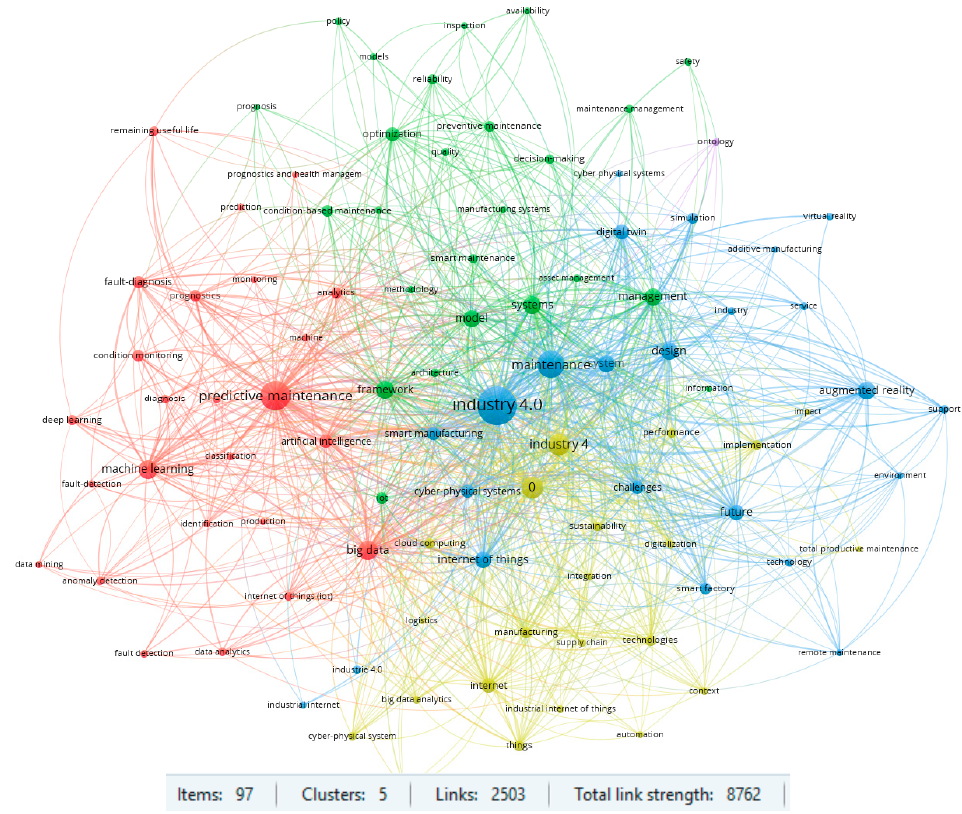
Figure 13. Analysis of keyword strength for the analyzed 1113 publications from the WoS database. Source: own development using VOSviewer software [101]. Two clusters for the item ‘predictive maintenance’ and for ‘Industry 4.0’ are particu- larly noteworthy in the area under review. The results of the strength of the links in the respective clusters are shown in Figures 14 and 15. The strength of linkages indicates a strong interest in Maintenance 4.0 issues in the context of predictive strategy and the In- dustry 4.0 concept. Previous review publications in the field of Maintenance 4.0 also con- firm such results. On the other hand, such keywords, like augmented reality, machine learning, or digital twin, also indicate the high strength of the links and suggest a potential direction for research in the area under consideration. An analysis of the database con- firms this conclusion in the context of the publication date. According to the results ob- tained, the most recent studies are about digital twins, deep learning, or smart factories.